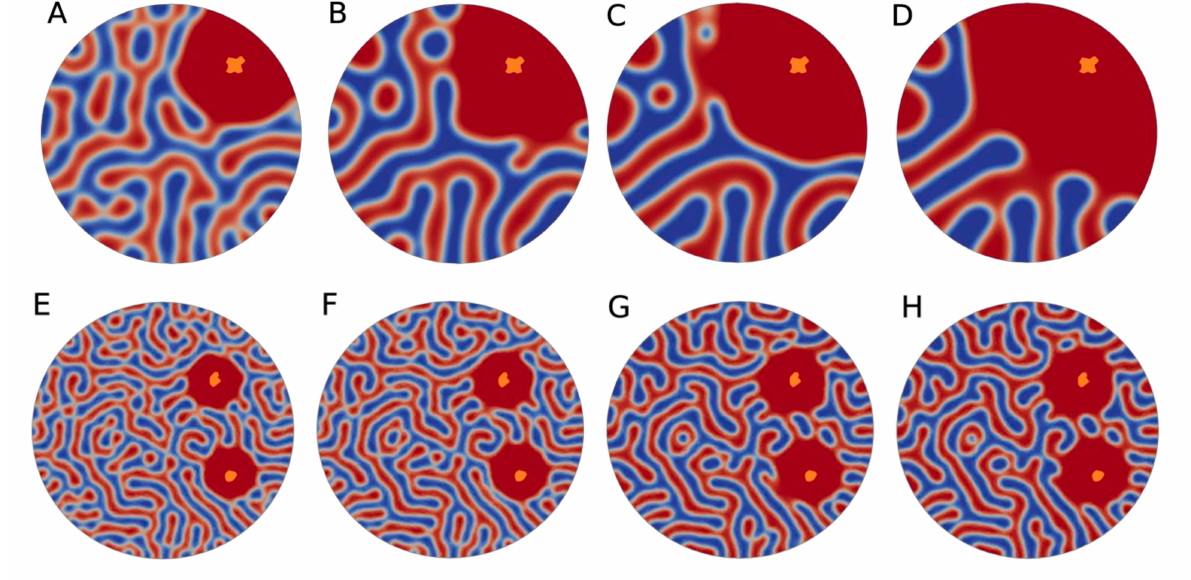
Figure 6. The effect of calcium phosphate granules on the inner membrane morphology. ( A – D ) Simulations on the effect of a single calcium phosphate granule on the mitochondrial cristae network. The Cahn–Hilliard (CH) equation was solved on a circle domain with a radius of five. The object with a white rim is the location of the calcium phosphate granule. The time step ∆ t = 0.005 for ( A ) t 300 , ( B ) t 800 , ( C ) t 1200 , and ( D ) t 1400 . ( E – H ) Two calcium phosphate granule loads of the Cahn–Hilliard equation on a circle domain with a radius of eight. The orange objects are the locations of the loaded calcium phosphate granules. The time step ∆ t = 0.001 for ( A ) t 375 , ( B ) t 400 , ( C ) t 850 , and ( D ) t 900 . As with Figure 3, the matrix and inter membrane spaces can be observed changing dynamically in response to the presence of calcium phosphate